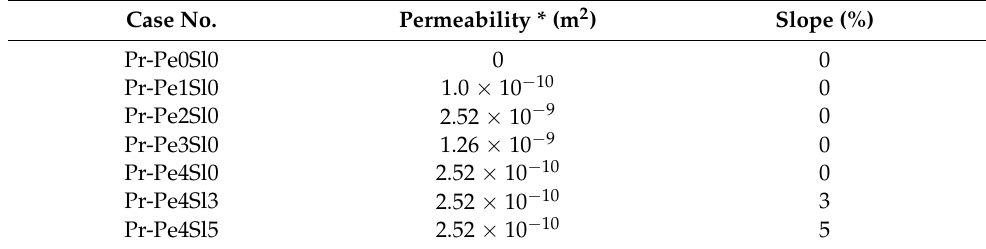
Figure 16. Schematic diagrams of model properties of prototype model: ( a ) normal drainage system; ( b ) IRD system with single; ( c ) IRD system with permeable block; ( d ) IRD system with slope and permeable block. Table 6. Results of mass conservation error of prototype model (with respect to time and space interval). Table 5. Boundary conditions of prototype Case No.